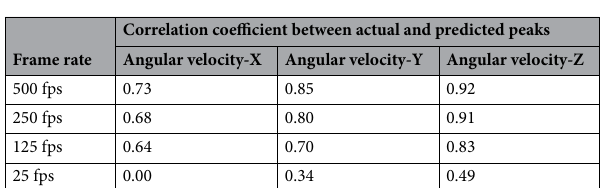
Figure 11. Correlation plots for ω x , ω y, and ω z .